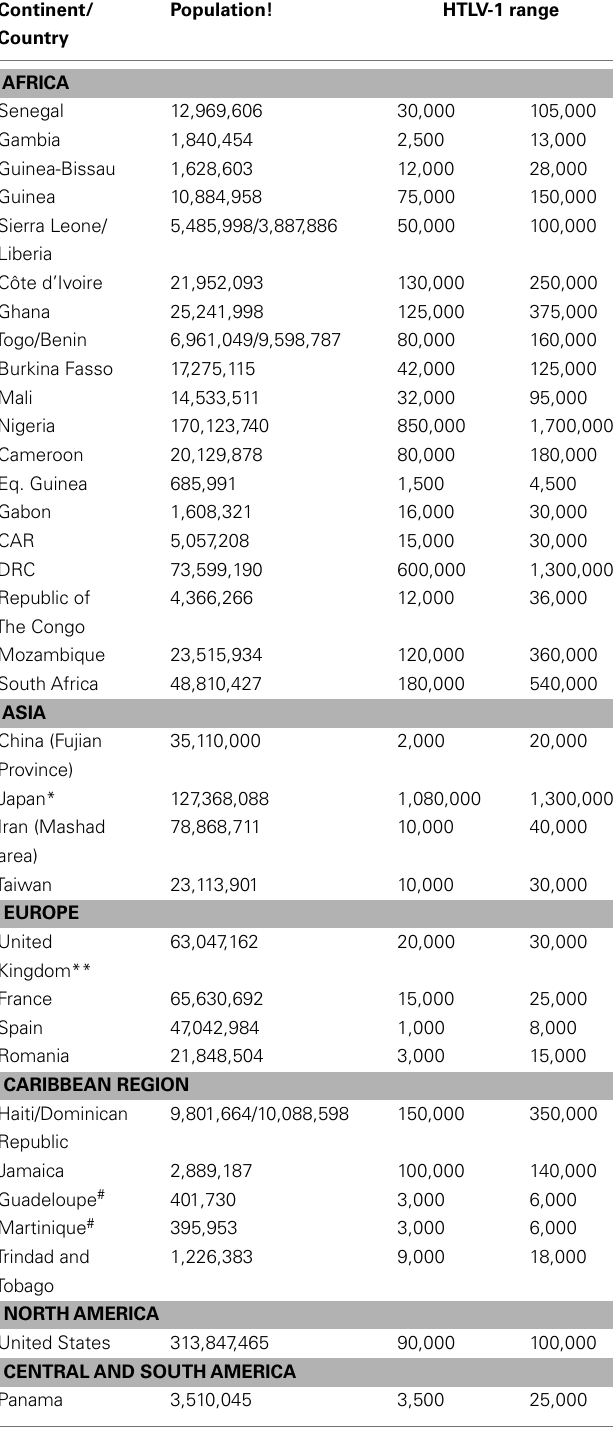
Table 2 | Estimates of the number of HTLV-1 infected carriers, based on approximately 1.5 billion of individuals from known HTLV-1 endemic areas and reliable epidemiological data obtained from studies performed among pregnant women and/or blood donors and/or different adult